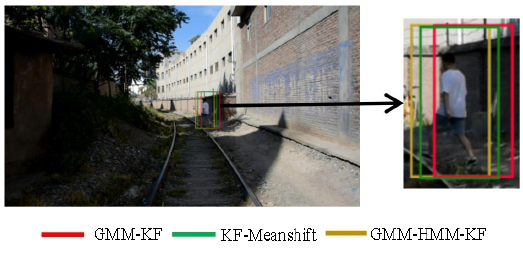
Fig. 8. The results of processing using three